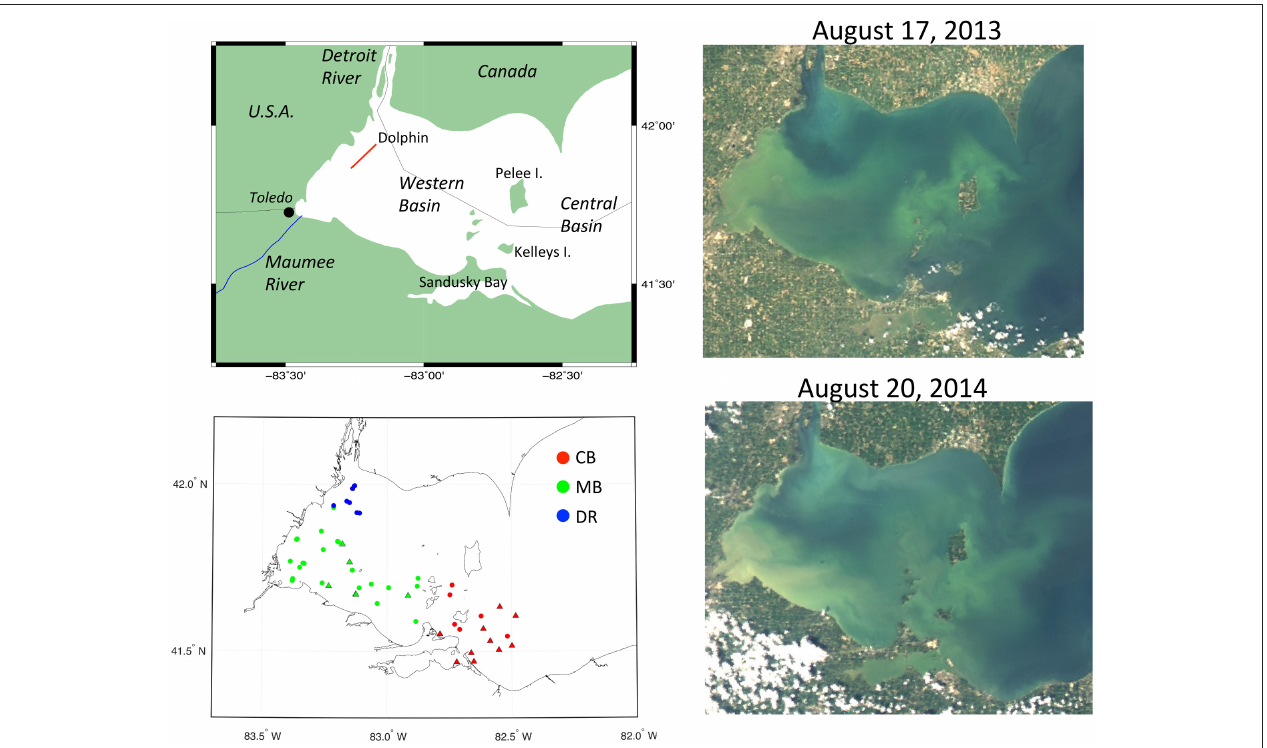
FIGURE 1 | Maps of western Lake Erie with station locations and satellite images. (Top left) Map with labels and Dolphin transect (red line); (Bottom left) station locations from mid-August 2013 and 2014 field measurements coded by hydrographic region (green, Maumee Bay waters; blue, Detroit River waters; red, Central Basin waters) and source (circles, UNH; triangles, NRL); (Top right) MODIS-Aqua true color image from August 17, 2013; (Bottom right) MODIS-Aqua true color image from August 20, 2014 (source: Optical Oceanography Laboratory, University of South